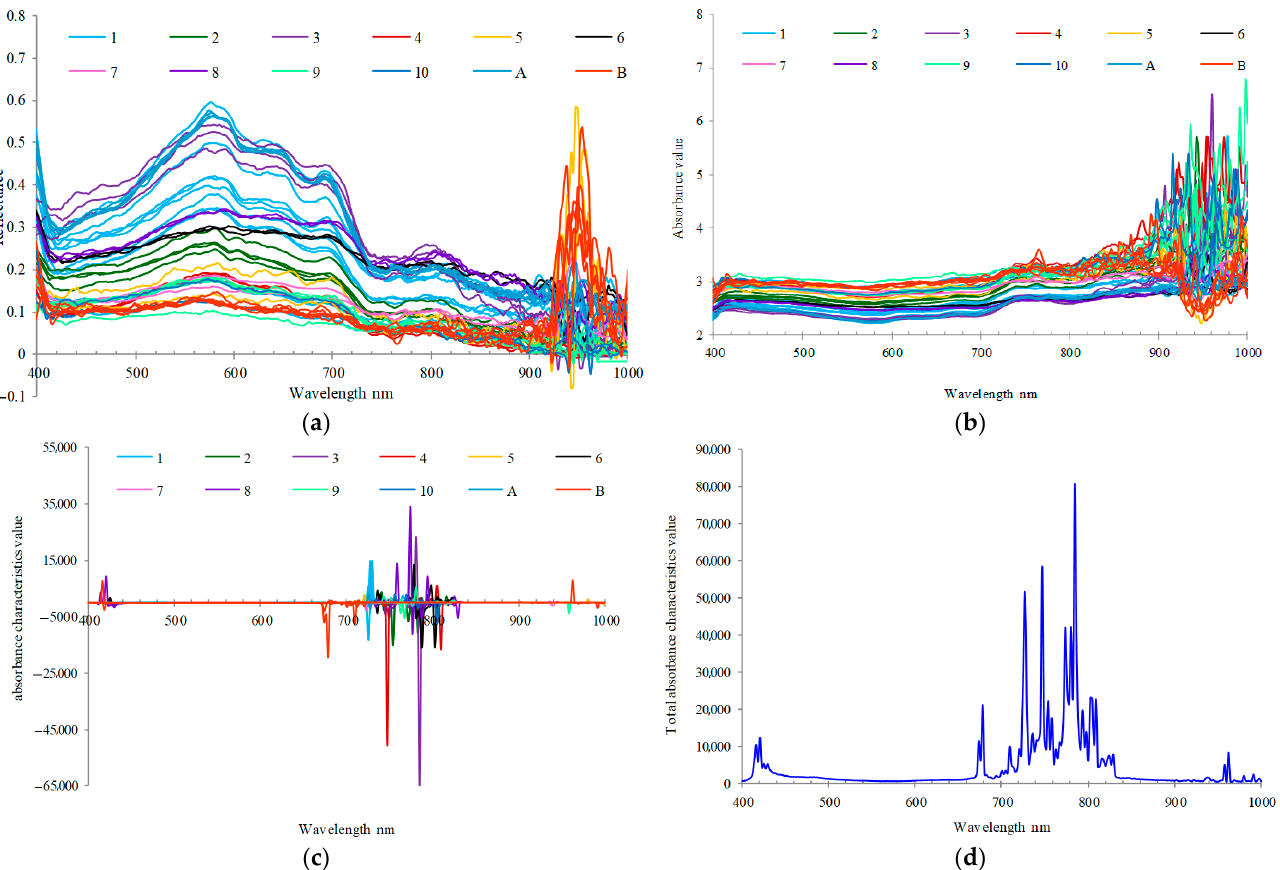
Figure 9. The spectral data, absorbance data, absorbance characteristics data, and total absorbance characteristics data of sampling points on each of the 10 strips and the spectral data of buoys A and B spectrometers. ( a ) The spectral data of sampling points; ( b ) the absorbance data of sampling points; ( c ) the absorbance characteristics data of sampling points; ( d ) the numerical ranking of 272 bands after passing the recognition algorithm of absorbance characteristics.